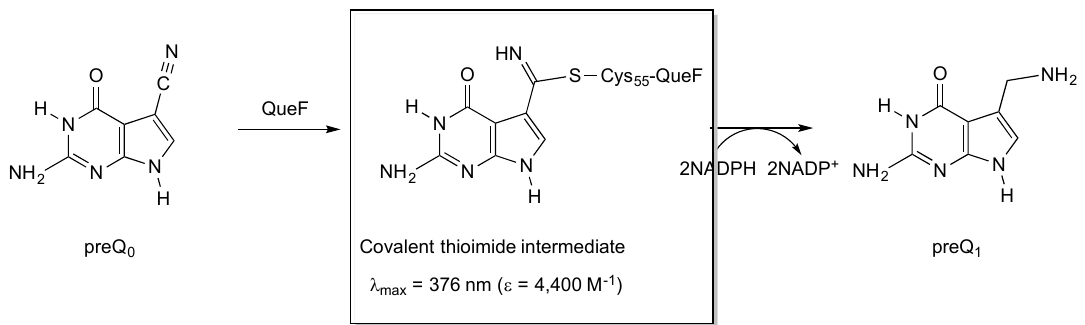
Figure 3. Structure and characteristics of the covalent thioimide intermediate formed in the QueF-catalyzed reaction in the biosynthesis of queuosine.